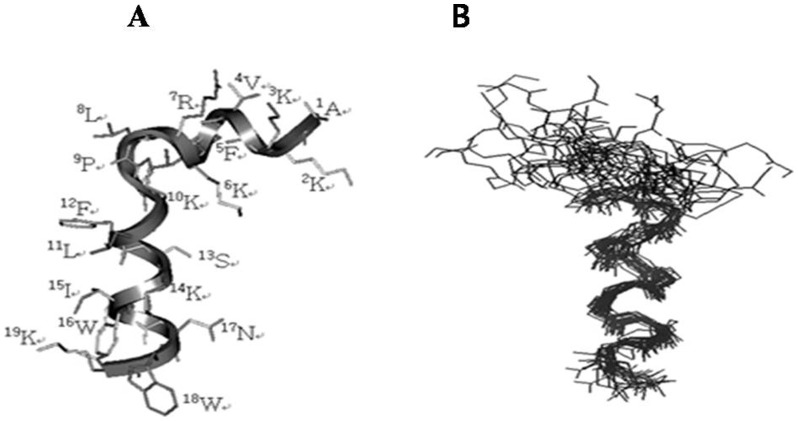
Tertiary structures.(A) Ribbon diagram of the lowest energy structure of Anal 3-Pro. (B) Superpositions of the 20 lowest energy structures calculated from the NMR data using the backbone atoms of residues 9–18.